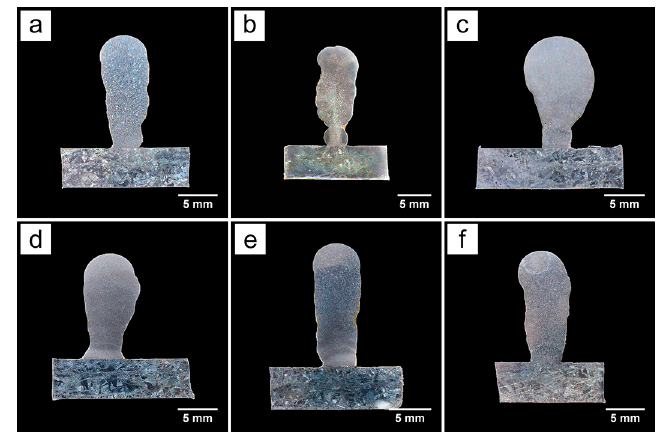
Figure 6. Cross sections of the samples deposited by different pulse frequencies: ( a ) 500 Hz; ( b ) 100 Hz; ( c ) 10 Hz; ( d ) 5 Hz; ( e ) 2 Hz and ( f ) 1 Hz.